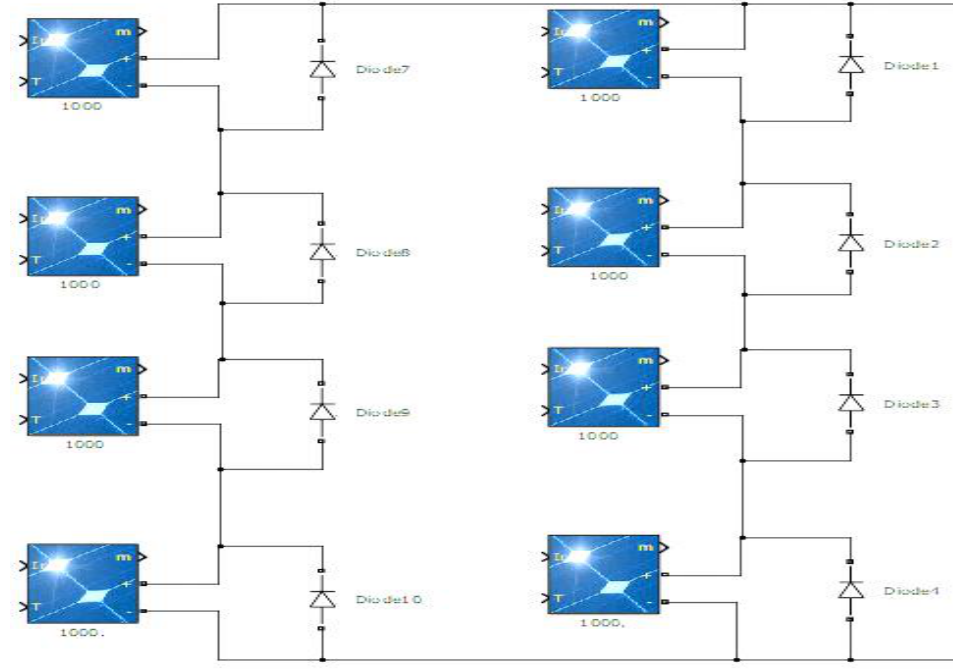
Fig. 6. A 4S2P solar photovoltaic test system